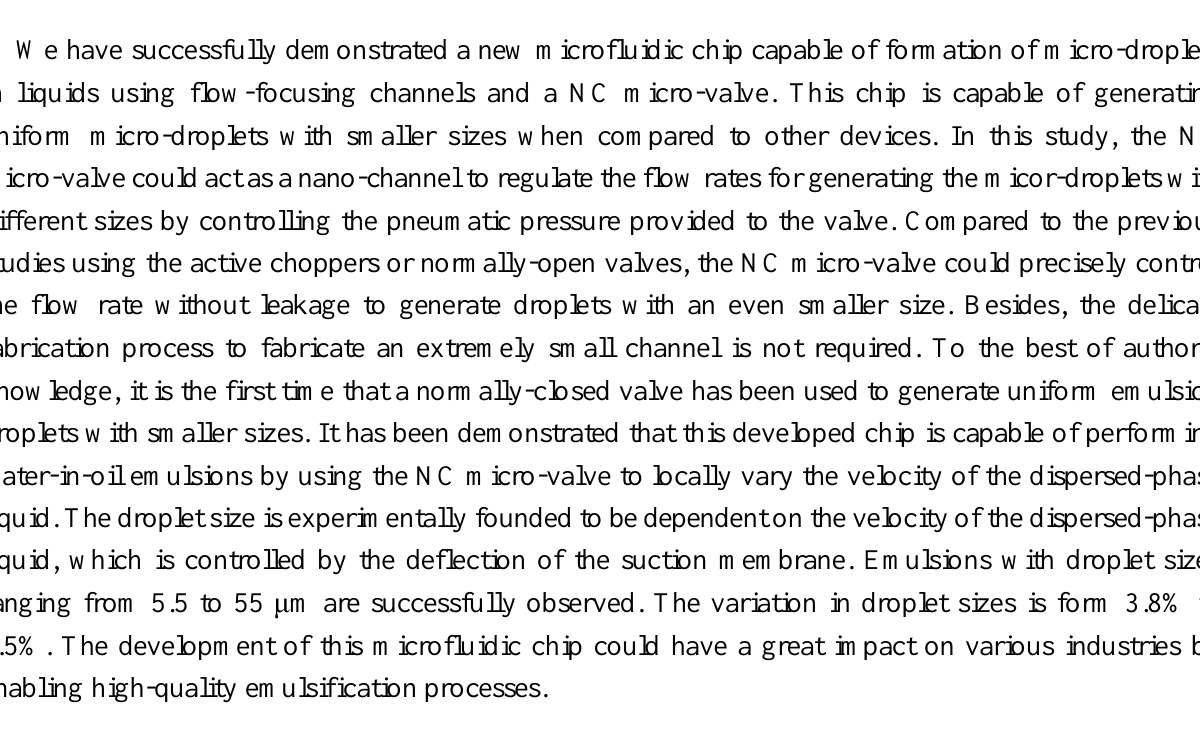
is 50 μm/s, and 2